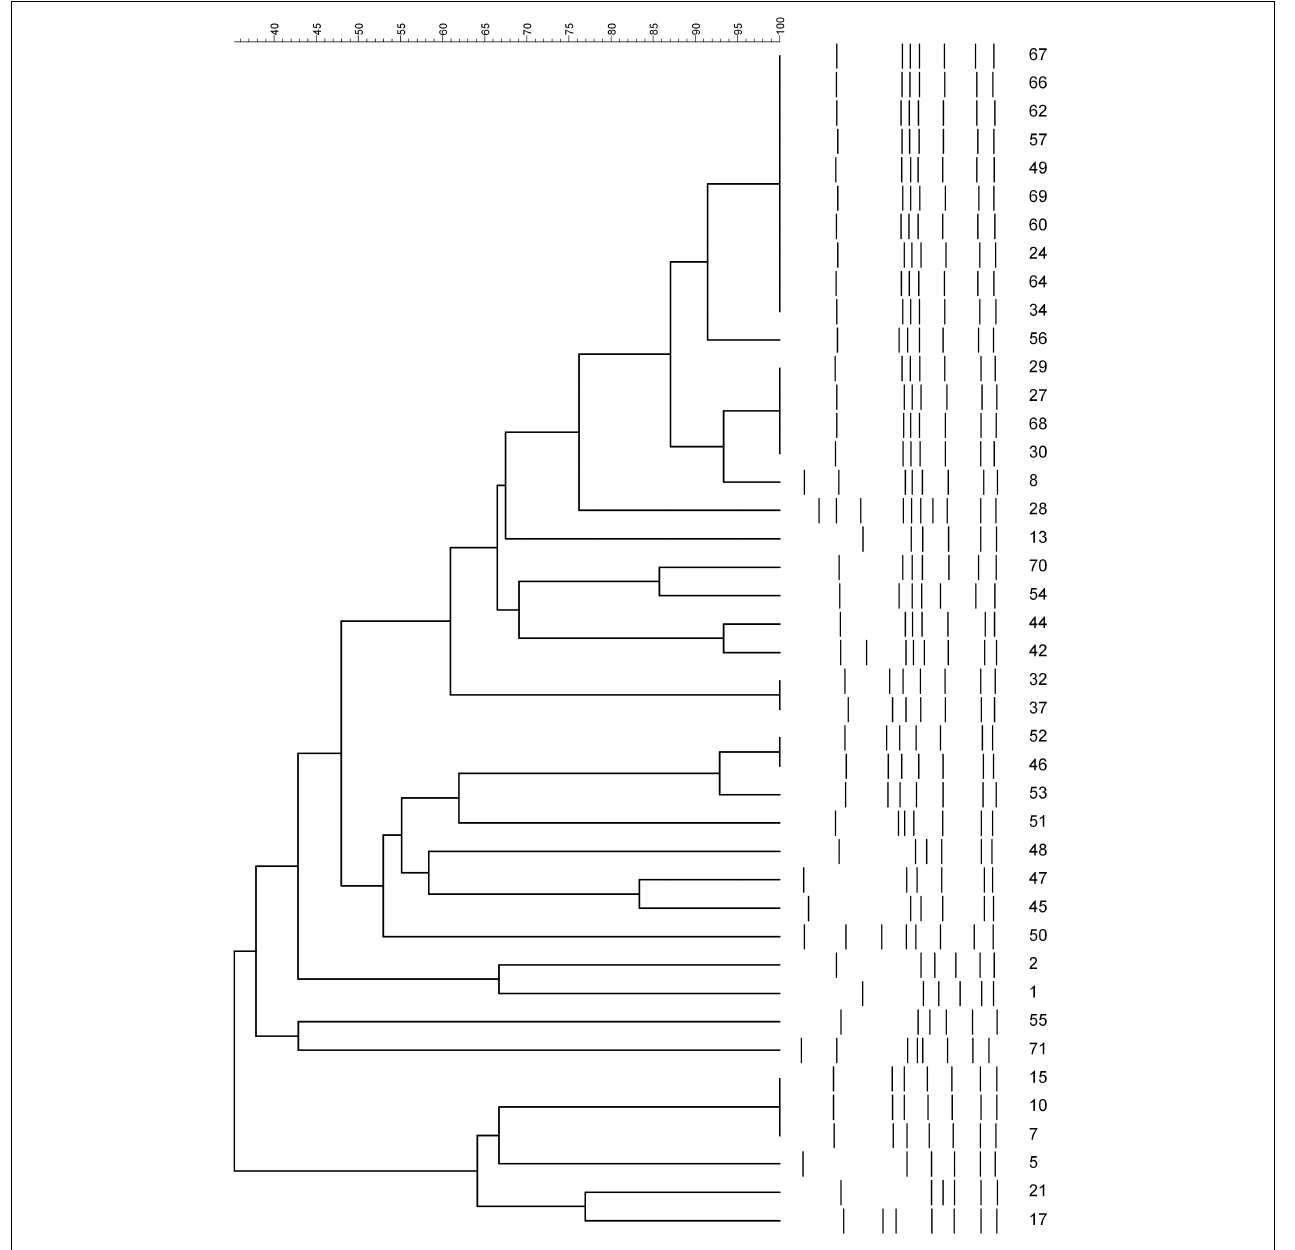
FIGURE 3 | PCR–restriction fragment length polymorphism profiles of fla A gene digested with HpyF31 from strains of Campylobacter species. Numbers represent the laboratory code for isolates.